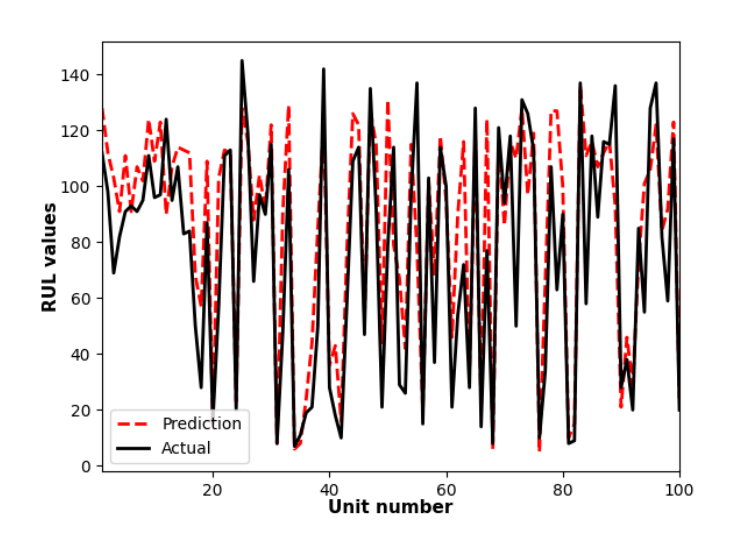
Figure 13. Comparision between the actual RULs and their prediction values.